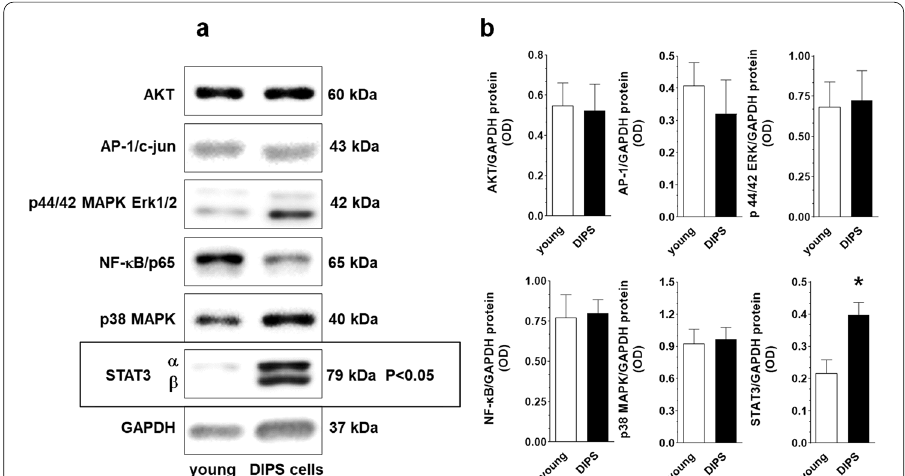
Fig. 4 DIPS‑associated change s in the protein level of kinases and transcription factors arbitrarily selected according to the literature as those being potentially involved in drug‑induced cancer cell senescence. Representative bands corresponding to certain signaling molecules analyzed using western blot ( a ) and their densitometric analysis with GAPDH used as the reference protein ( b ). In order to reduce the risk of incorrect observations due to cellular hypertrophy in senescent cells, SDS‑PAGE was performed using samples corresponding to the experimentally optimized number of cells (3–5 10 4 ). The results derive from 5–6 × independent experiments on HGSOCs from different